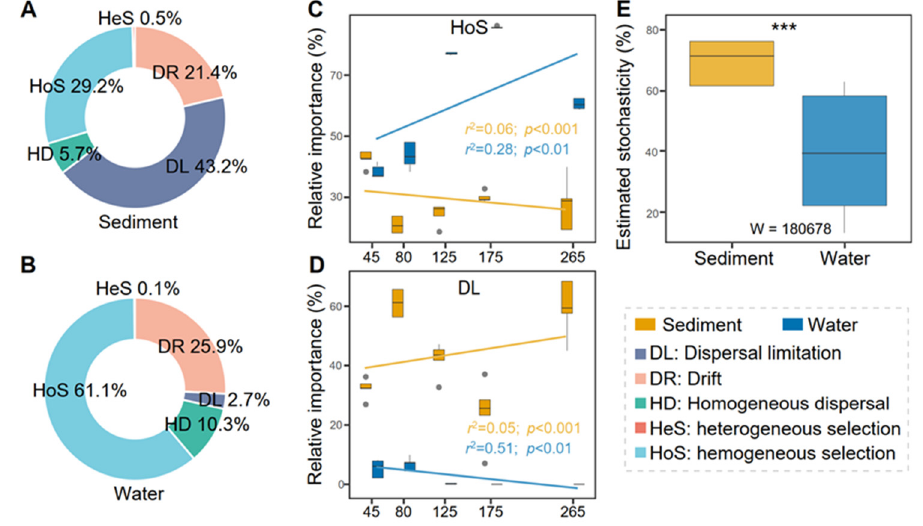
Figure 6. Relative importance of different ecological processes in salterns’ sediment and water. ( A ), Relative importance of different ecological processes in sediment samples. ( B ), Relative importance of different ecological processes in water samples. ( C , D ) Changes of homogeneous selection and dispersal limitation in sediment (orange box) and water (blue box). The adjusted r 2 and p values from linear regressions are shown. ( E ) Stochasticity estimated in both sediment and water samples. Mann–Whitney U test results are shown, and significance is expressed as *** p ≤ 0.001.